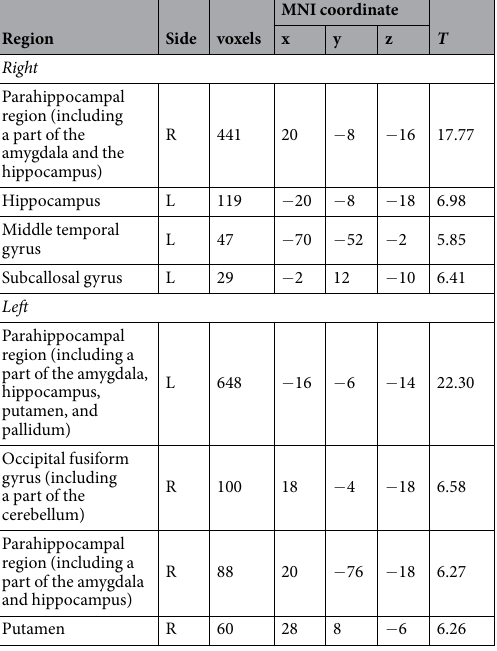
Table 2. Amygdala-centred functional connectivity during fearful faces processing Seed region is the amygdala whose cluster showed significantly increased activation in response to fearful faces (vs. neutral faces): L-Amy: MNI − 21–10–17, 351 mm 3 , R-Amy: MNI 21 -10 -17, 189 mm 3 . These clusters are comprised of the caudomedial portion of the amygdala. Significant at whole-brain FDR-corrected p <